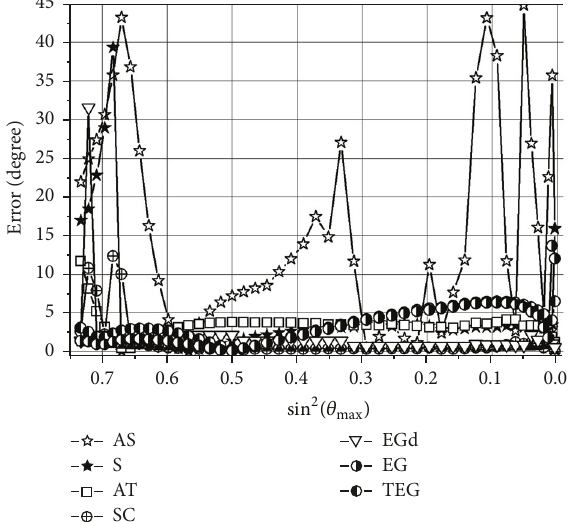
Figure 4: Techniques of low quality, variant 𝑉 𝑃3 = 4800 . The error for the fixed minimum